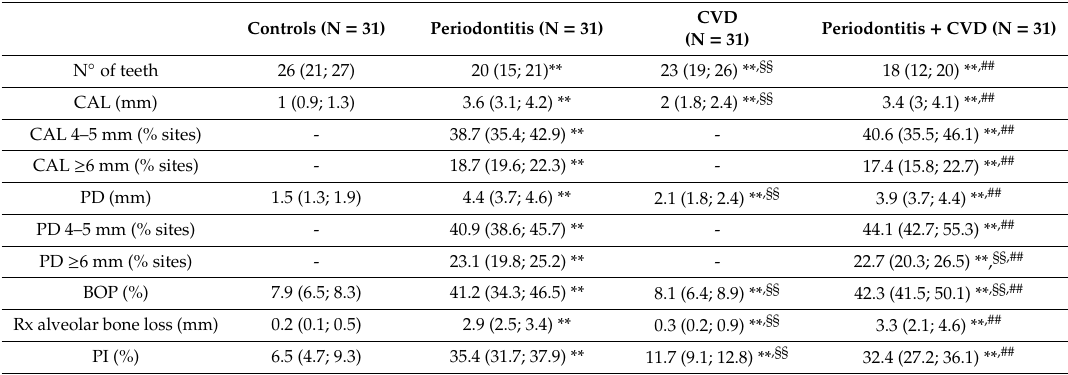
Table 2. Periodontal characteristics of enrolled patients. Data are represented as median (25th; 75th percentile). CAL, clinical attachment level; PD, probing pocket depth; BOP, bleeding on probing; PI, plaque index. ** p < 0.001 significant di ff erences vs. control subjects. §§ p < 0.001 significant di ff erences vs. periodontitis patients. ## p < 0.001 significant di ff erences vs. CHD patients.